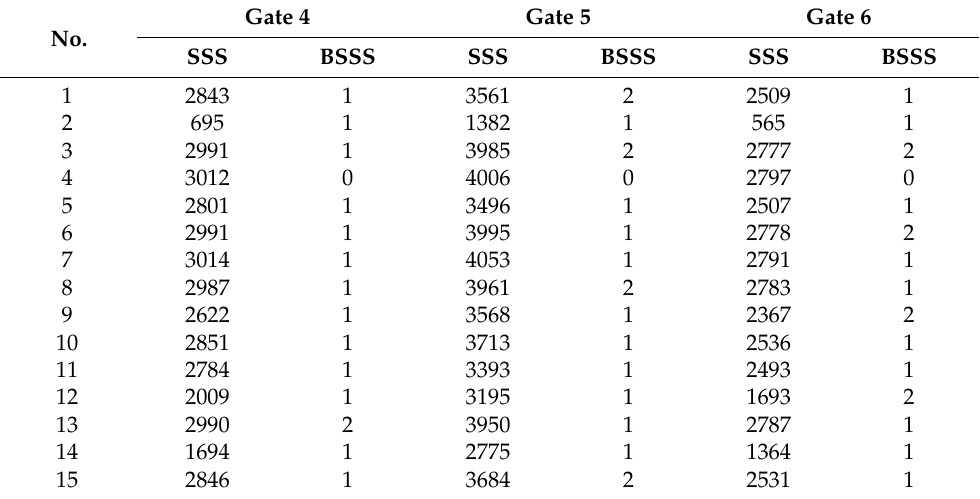
Table 8. Number of slope-similar shapes for each query in each